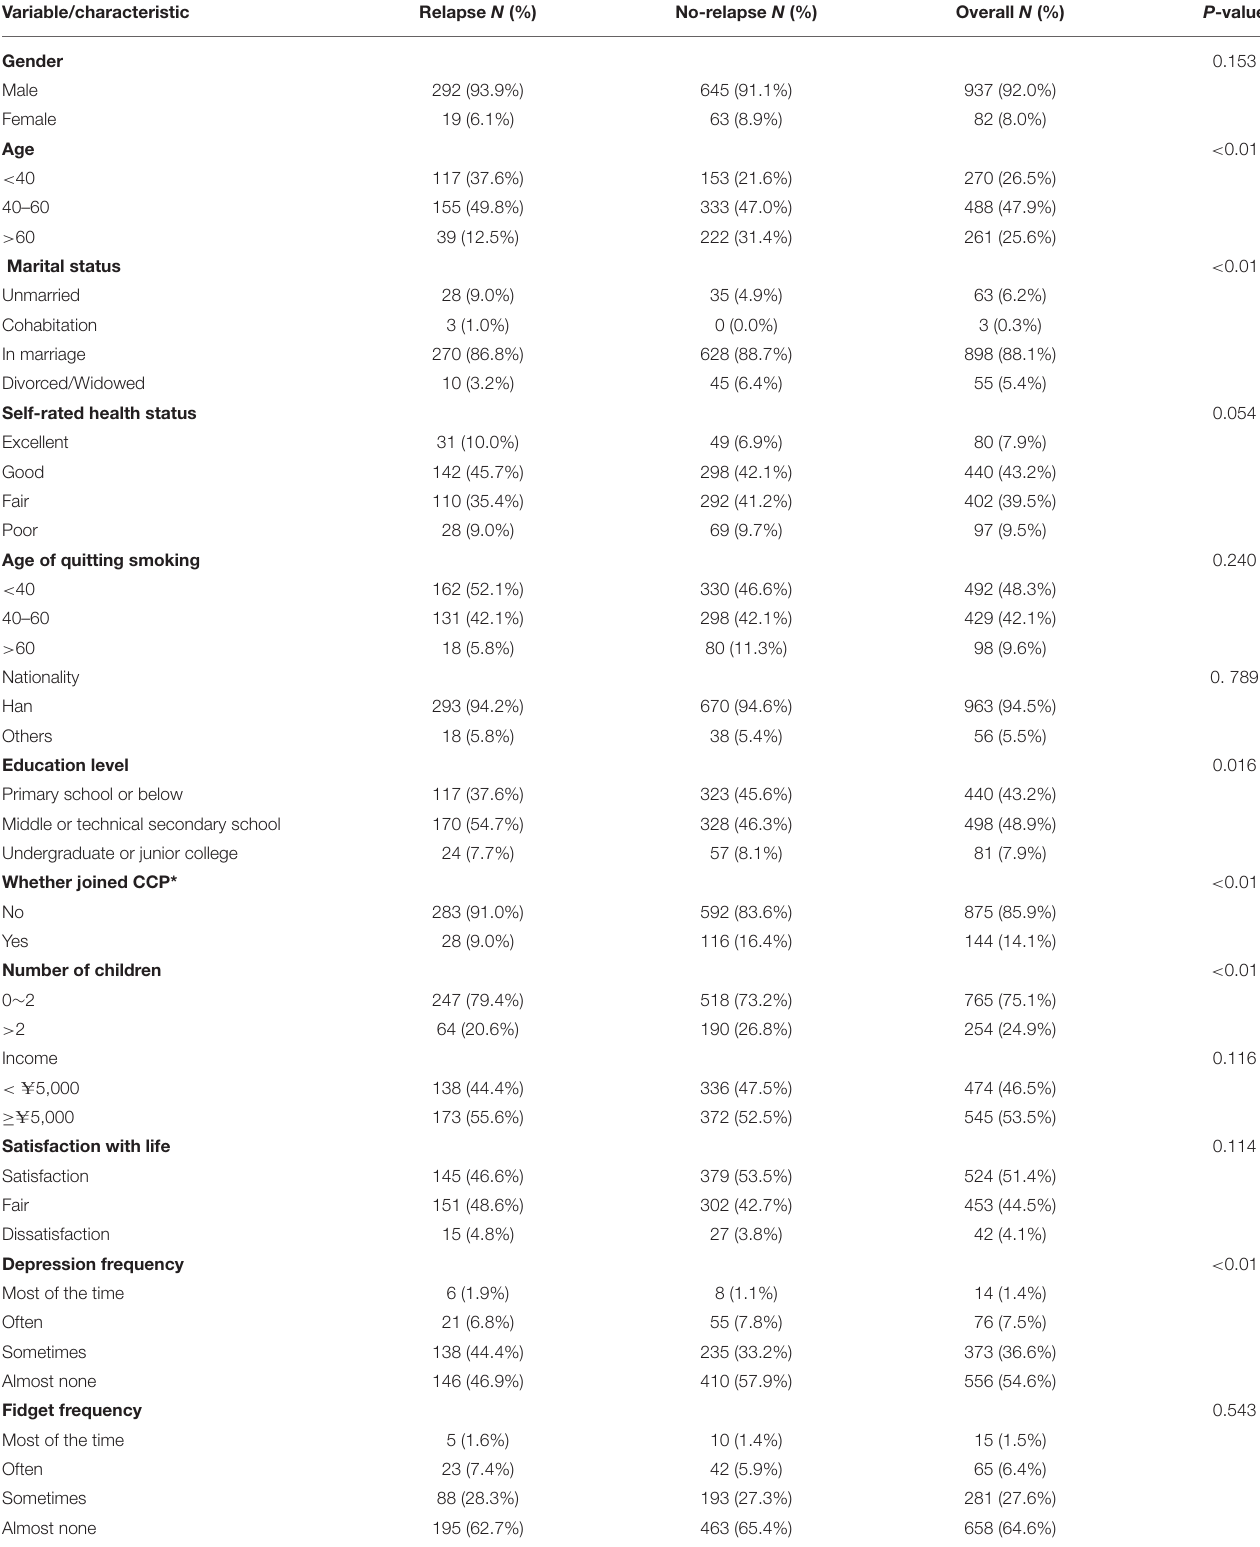
TABLE 1 | Distribution characteristics and univariate analysis of relapse and non-relapse population.